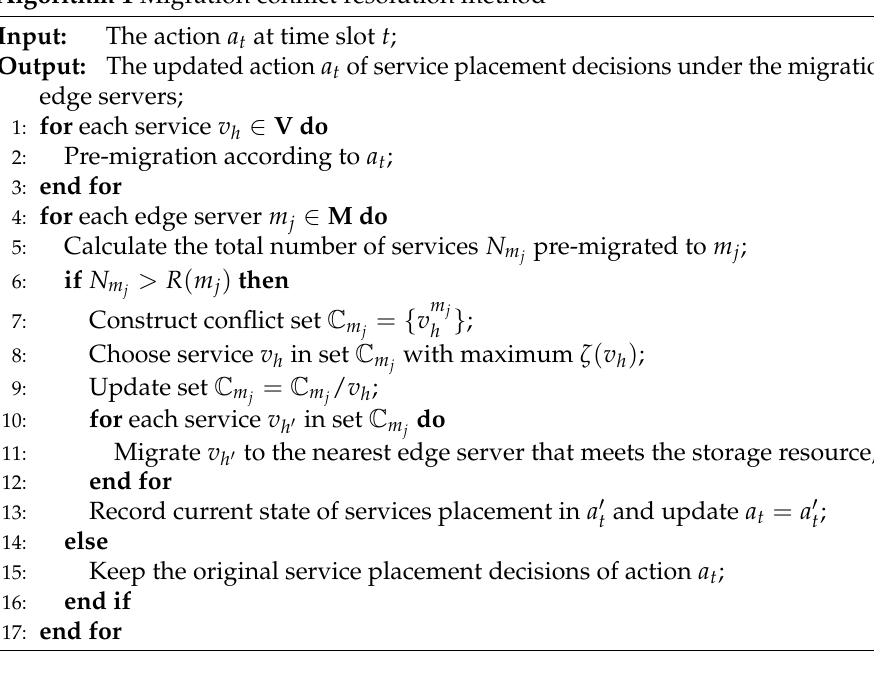
Algorithm 1 Migration conflict resolution